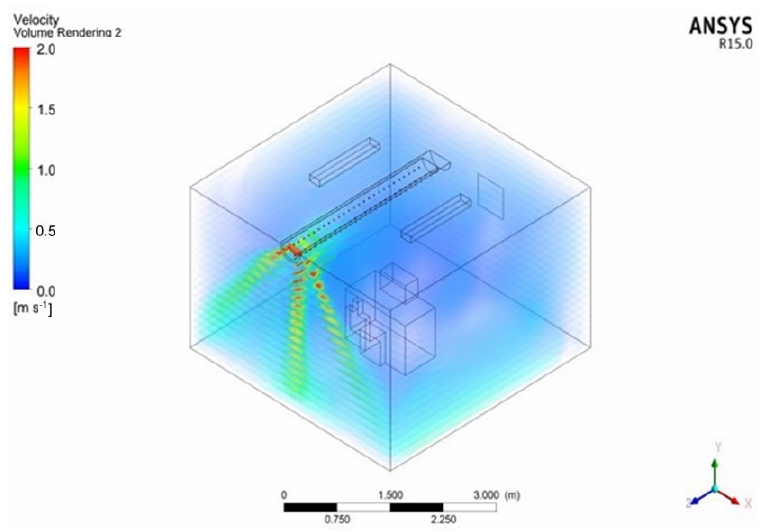
Figure 20. The schematic diagram of the air supply of the split-fiber air conditioner with the air outlet opposite the human body.